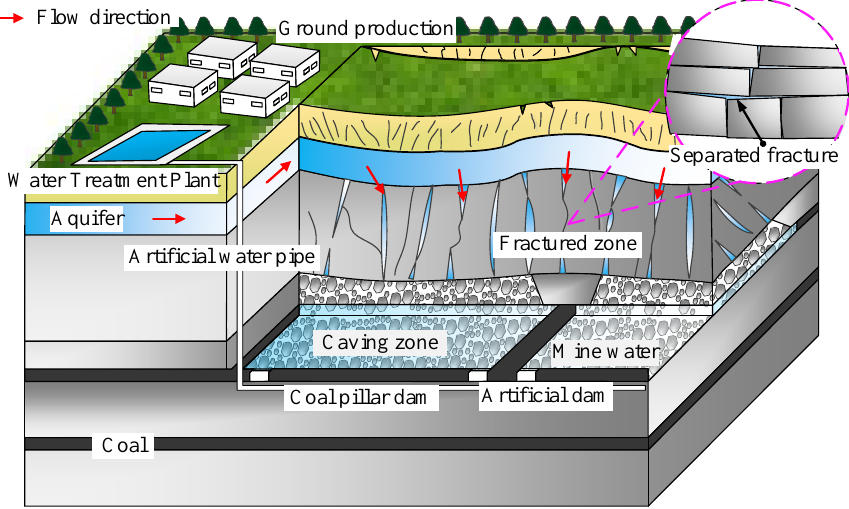
Figure 1. Schematic diagram of the coal mine underground reservoir. Regarding research on the storage capacity, storage coefficient, and voids of broken rock in underground reservoirs in coal mines, Zhang et al. [12] determined the relationship between the storage and hulking coefficients of the gangue. Ju et al. [13] deduced that the storage capacity of an underground reservoir is the sum of the free space between the gangue of the caving zone and the separation gap of the fractured rock formation in the fracture zone. The equation for the storage capacity of the coal mine underground reservoir was established based on the key stratum theory and the parabolic space morphological model of the caving zone. Pang et al. [14] calculated the volume difference before and after the caving of the rock formation using the vertical displacement locus equation of overburden separation, built a theoretical calculation model for the storage space of a coal mine underground reservoir, and verified the reliability of the model through